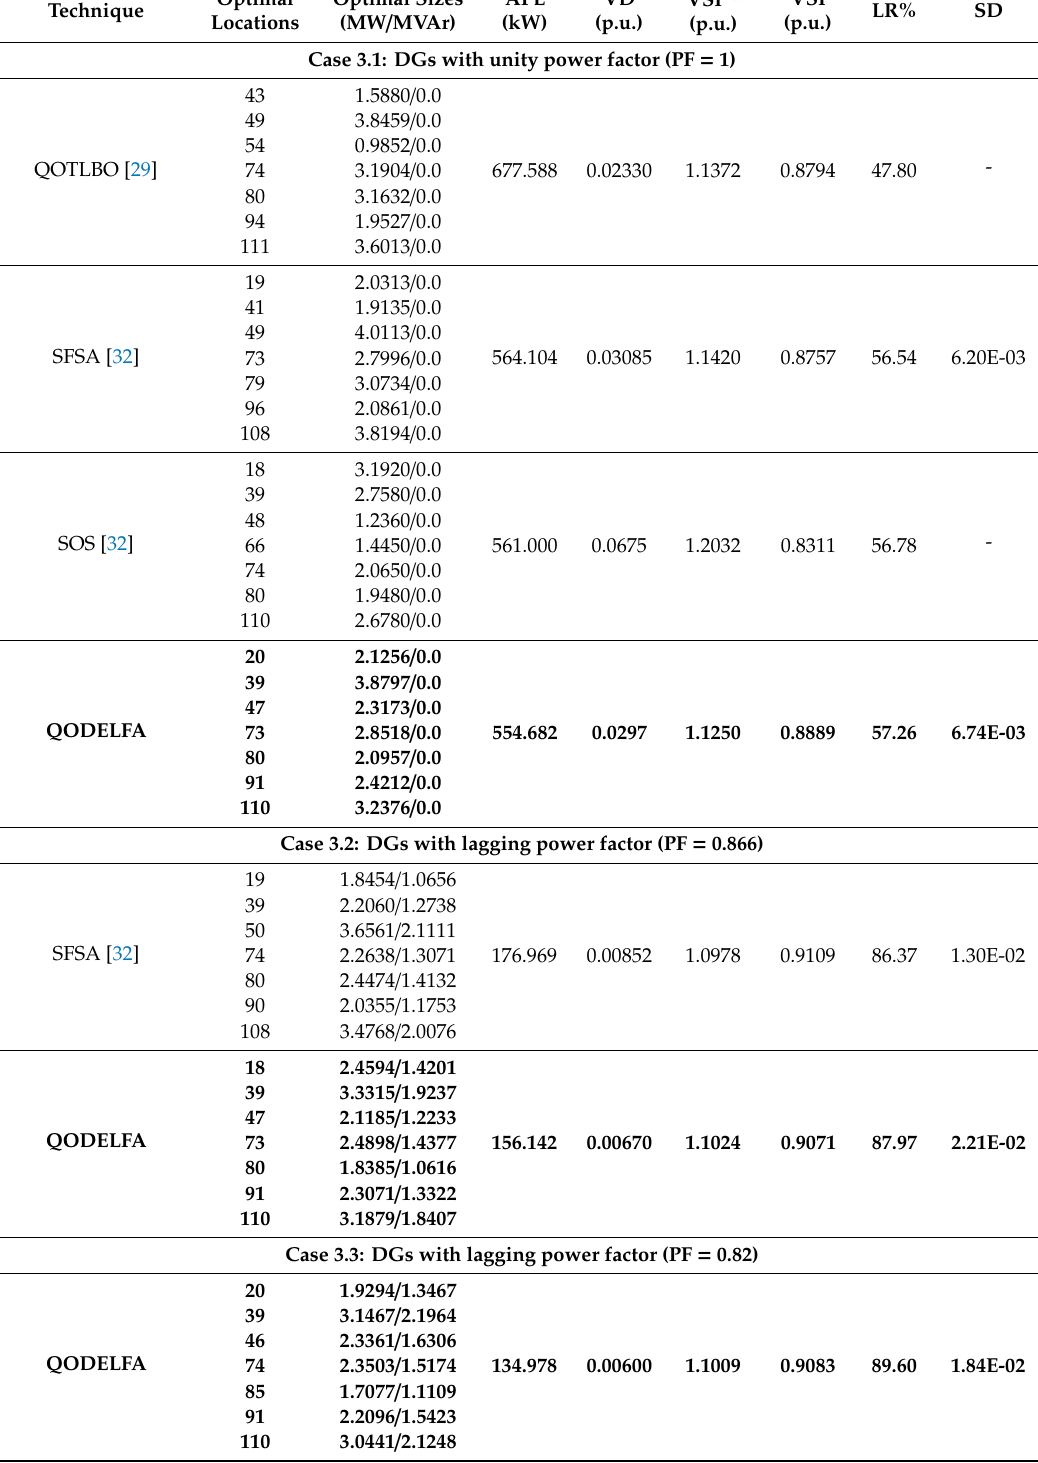
Table 11. Results for the IEEE 118-bus RDS with simultaneous minimization of OF 1 , OF 2 , and OF 3 .